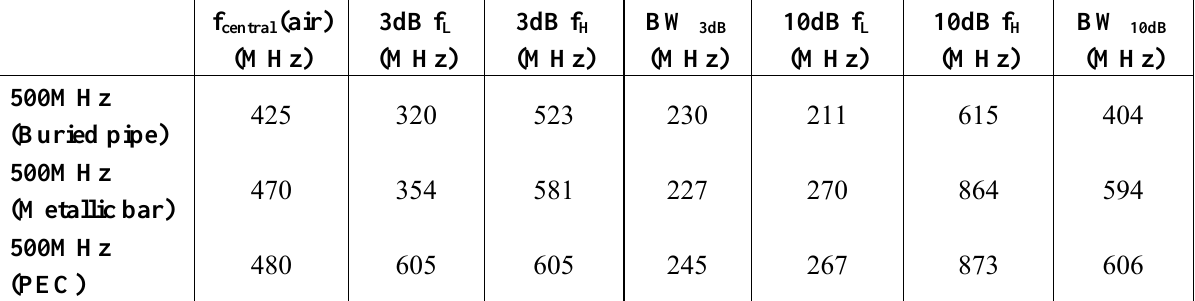
Table 2. Frequency characteristics of the effective wavelets obtained with the proposed